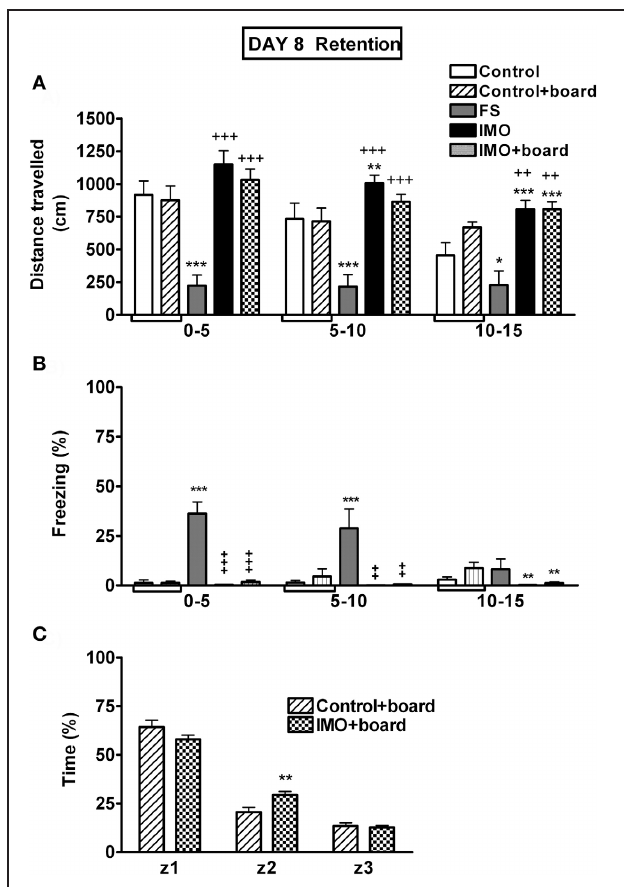
FIGURE 6 | Behavioral data for Experiment 3 on day 8 (retention). Means and SEM are represented. The groups were: control, rats exposed for 20min to the chamber without shocks; FS, rats allowed to explore the chamber for 5min and then exposed to shocks for 15min; and IMO, rats allowed to explore the chamber for 5min and then exposed to IMO inside the chamber for 15min. On day 8 control and IMO rats were tested without the presence of the board or with the board (control-board and IMO-board groups). Control and control+board groups are presented separately in the graphs but they were pooled for the statistical analysis. Panel (A) shows distance traveled during the 15min exposure to the chamber (5min blocks). Panel (B) shows freezing during the 15min exposure to the chamber (5min blocks). Panel (C) shows time spent in the area were the board was located (z1), in the intermediate area (z2) or in the opposite area (z3). ∗ , ∗∗ , ∗∗∗ : p < 0 . 05, p < 0 . 01 and p < 0 . 001 vs. control group; + , ++ , +++ : p < 0 . 05, p < 0 . 01 and p < 0 . 001 vs. FS group.